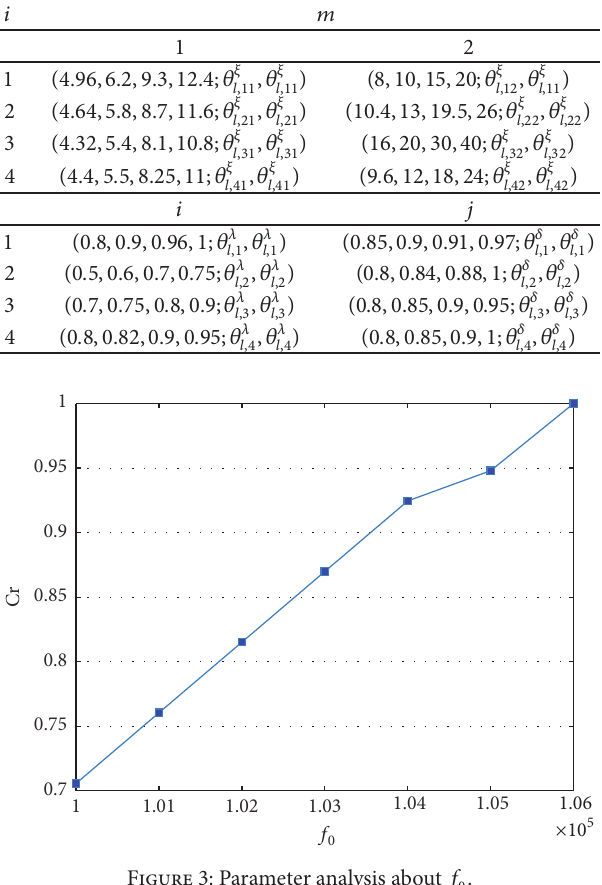
Figure 3: Parameter analysis about 𝑓 0 .